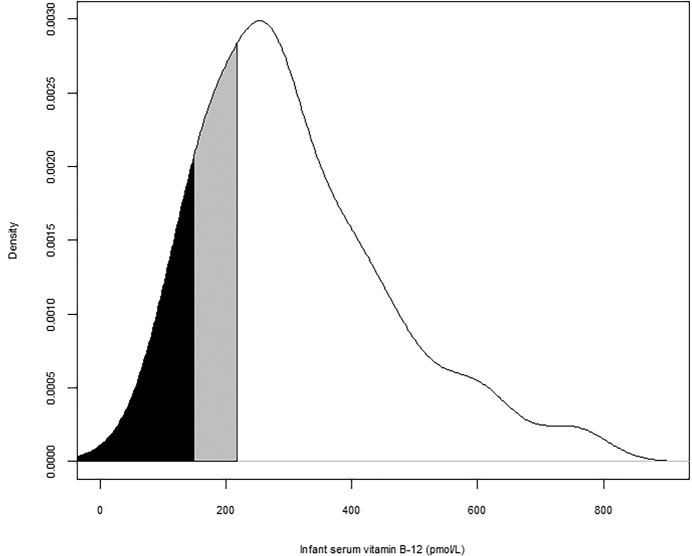
Kernel density plot of infant serum vitamin B-12 concentration within a subsample of the WASH Benefits, Kenya biochemical substudy (n = 176). The areas shaded black and gray represent the proportion of the population that had serum vitamin B-12 concentration <148 pmol/L (indicative of deficiency), and >148 pmol/L but <220 pmol/L (indicative of depletion), respectively. The y-axis values, density, represent the relative likelihood of vitamin B-12 concentration among this population (e.g., a density of 0.002 multiplied by 150 pmol/L = 0.3); the AUC sums to 1. WASH, Water Sanitation and Hygiene.